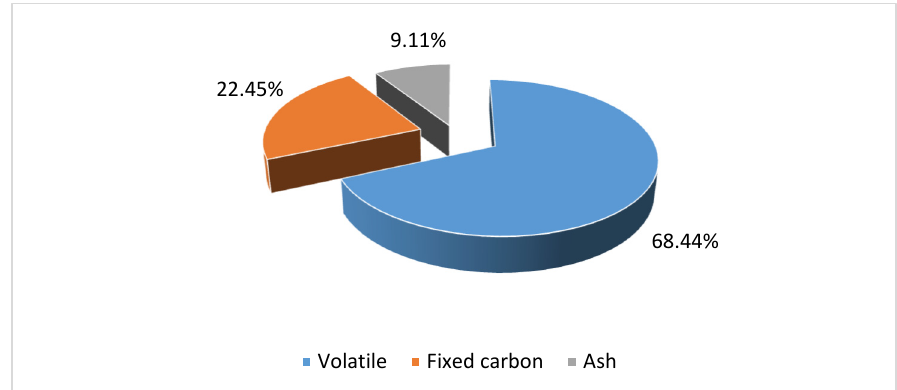
Figure 9. Content of ash, volatile content, and fixed carbon for wheat straw.